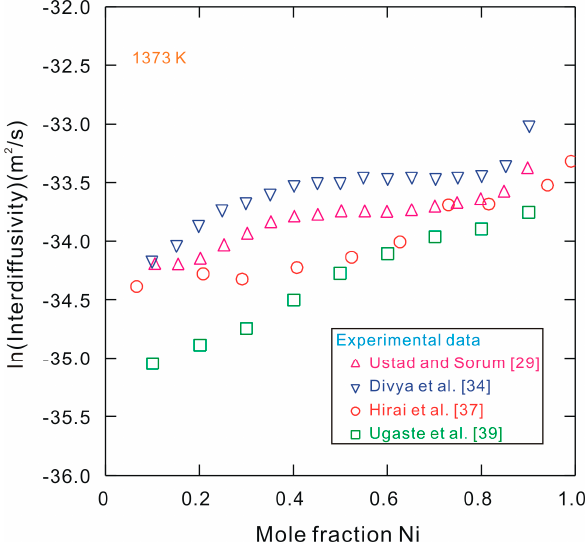
Figure 1. Natural logarithm of interdiffusivities in fcc Co–Ni system at 1373 K, reported from the literature [29,34,37,39].